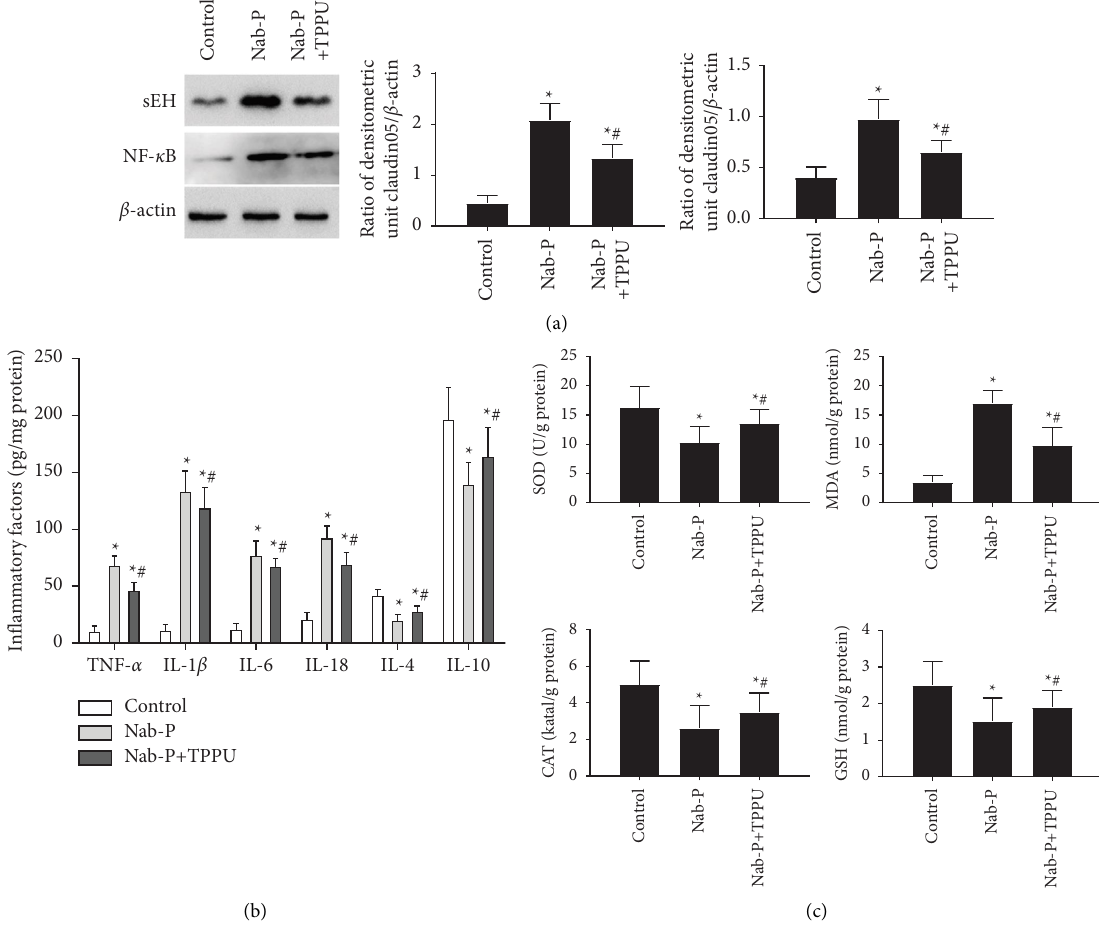
Figure 5: sEH/NF- κ B pathway-induced infammatory factors and oxidative stress are involved in peripheral neuropathy induced by nab- paclitaxel. (a) Western blotting was used to detect the expression of sEH and NF- κ B. (b) Efects of TPPU on the levels of infammatory factors, including TNF- α , IL-1 β , IL-6, IL-4, and IL-10, in the rat spinal cord were determined by ELISA. (c) Oxidative stress was present as the levels and activities of SOD, CAT, MDA, and GSH in the spinal cord. n � 6; ∗ P < 0 . 05 compared to the control group, # P < 0 . 05 compared to the nab-P